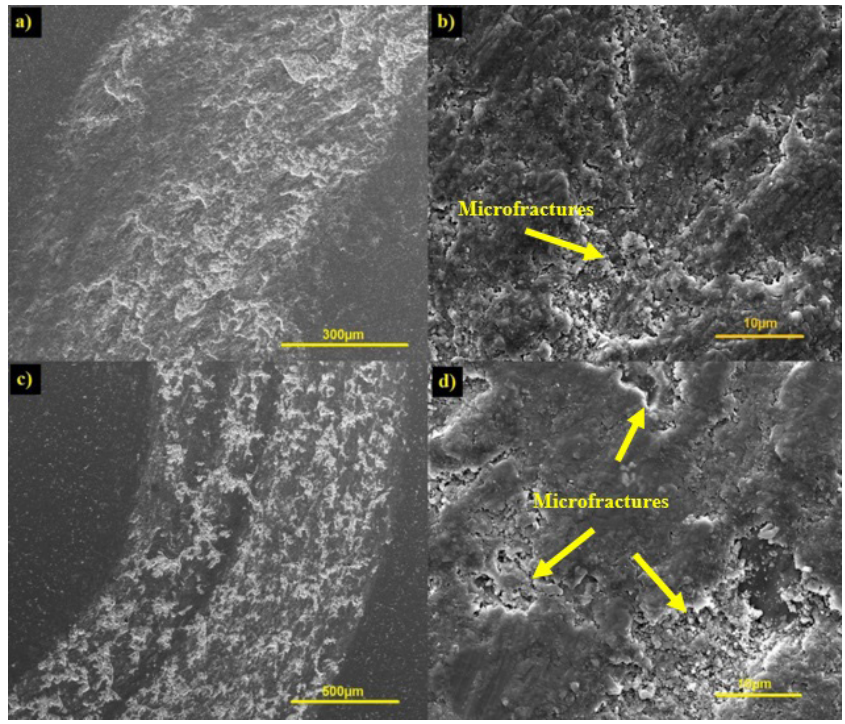
Figure 5. Secondary electron micrographs of the wear tracks and wear zones on A85N15 (a,b) and A95N5